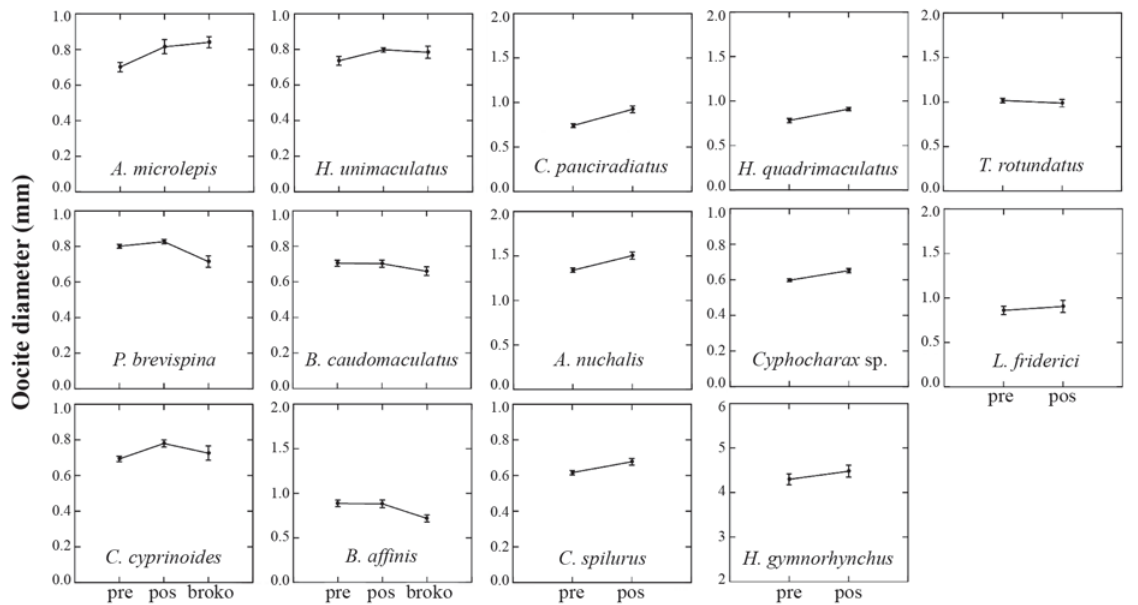
Fig. 4. Comparison of mean mature oocyte size of the 14 studied species in the different situations. pre = Sinnamary River 1994- 1996, pos = Petit-Saut Reservoir 2002-2003, broko = Brokopondo Reservoir 2002-2003.